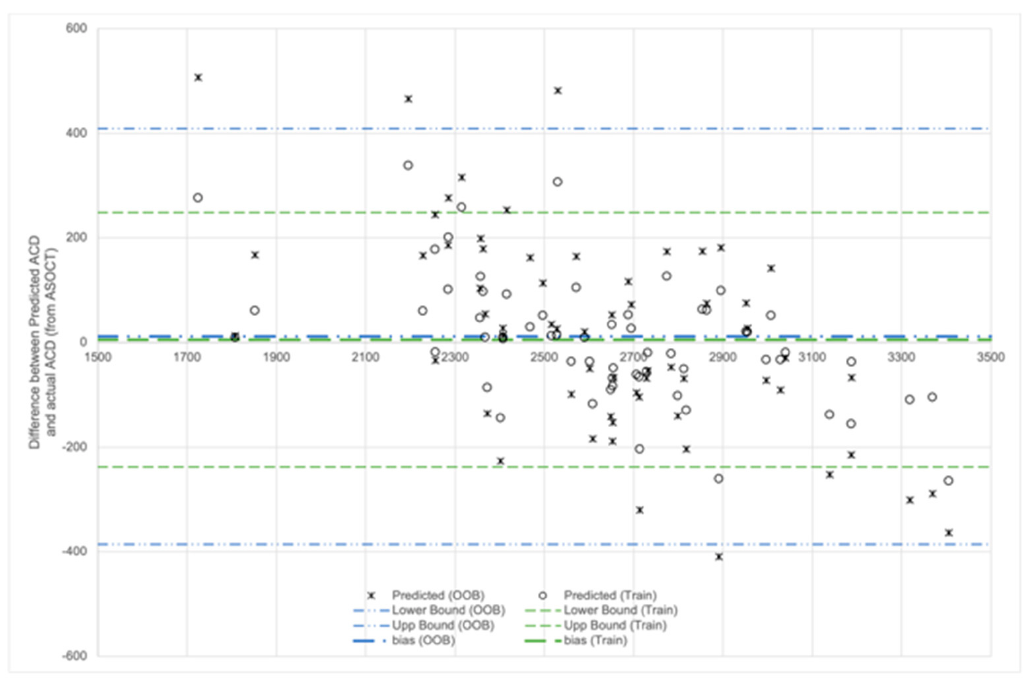
Figure 4. Bland–Altman plot showing ASOCT-derived ACD and predicted values from the training inputs and the out-of-bag samples. Table 2. Features importance (normalized) calculated based on Gini-impurity.